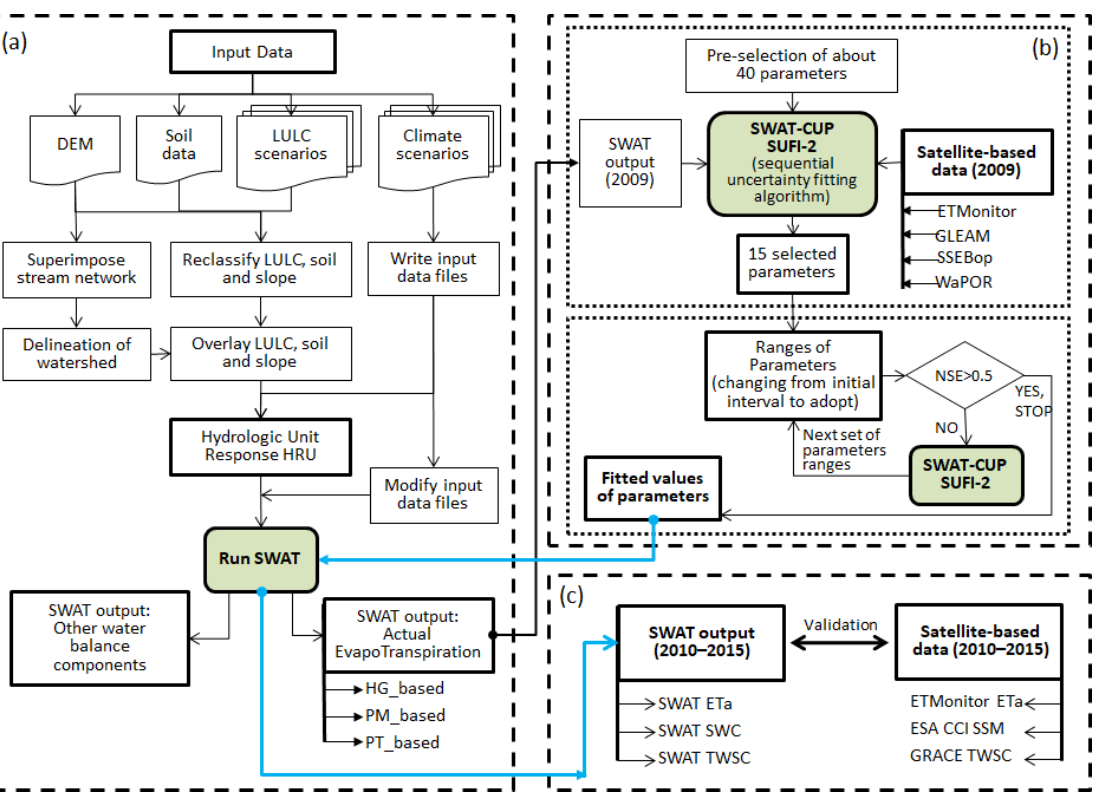
Figure 2. The conceptual framework of this study: ( a ) the SWAT flowchart (and uncalibrated model outputs), ( b ) SWAT-CUP flowchart (parameter selection and calibration), and ( c ) the validation schemes (using the calibrated model).